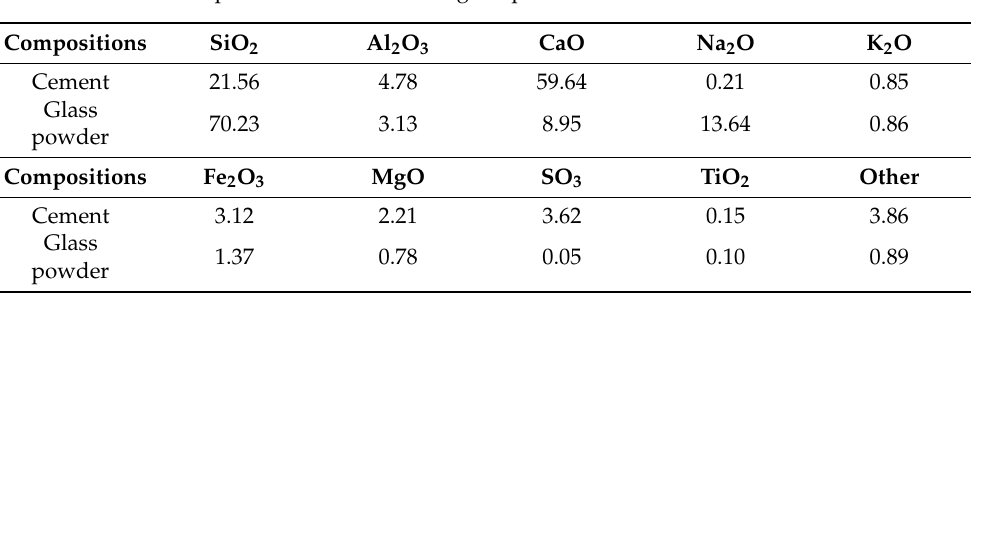
Table 2. Chemical compositions of cement and glass